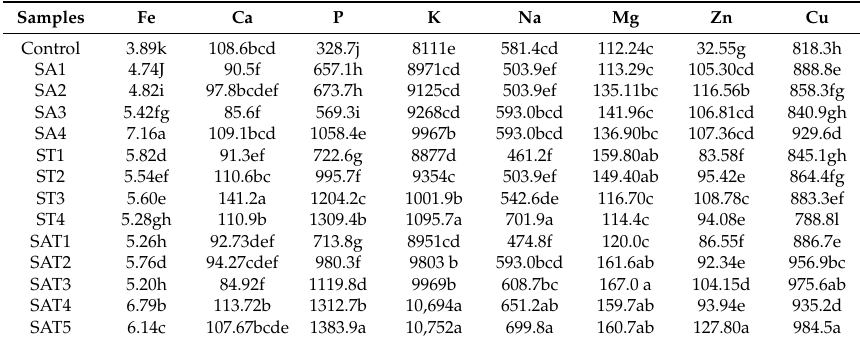
Table 4. Mineral composition of the formulated composite powder (mg/100